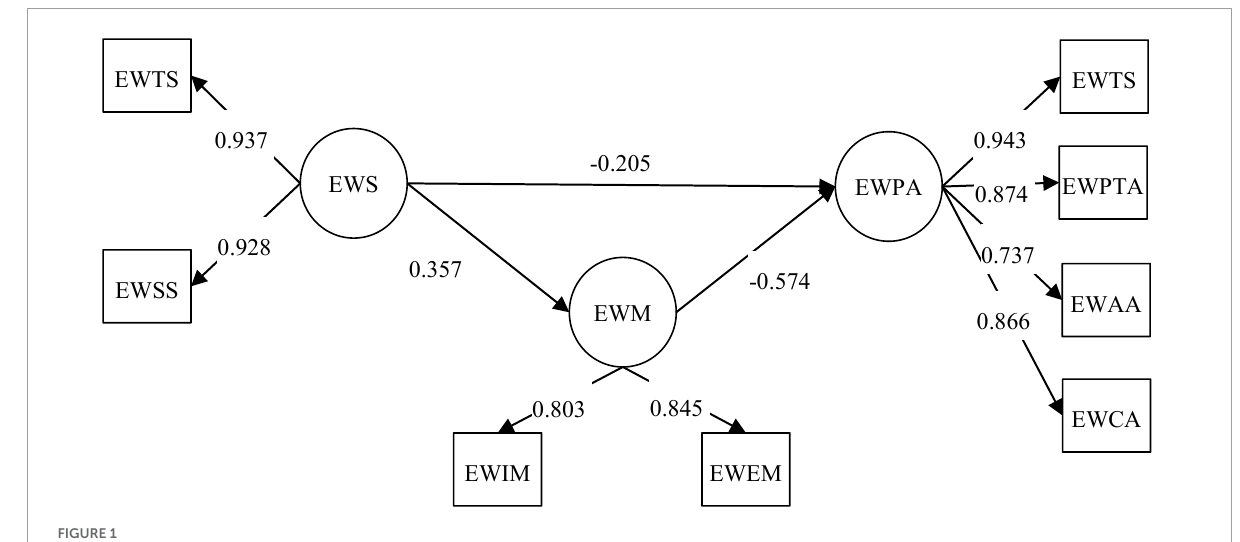
FIGURE1 Results of the mediating effect of writing